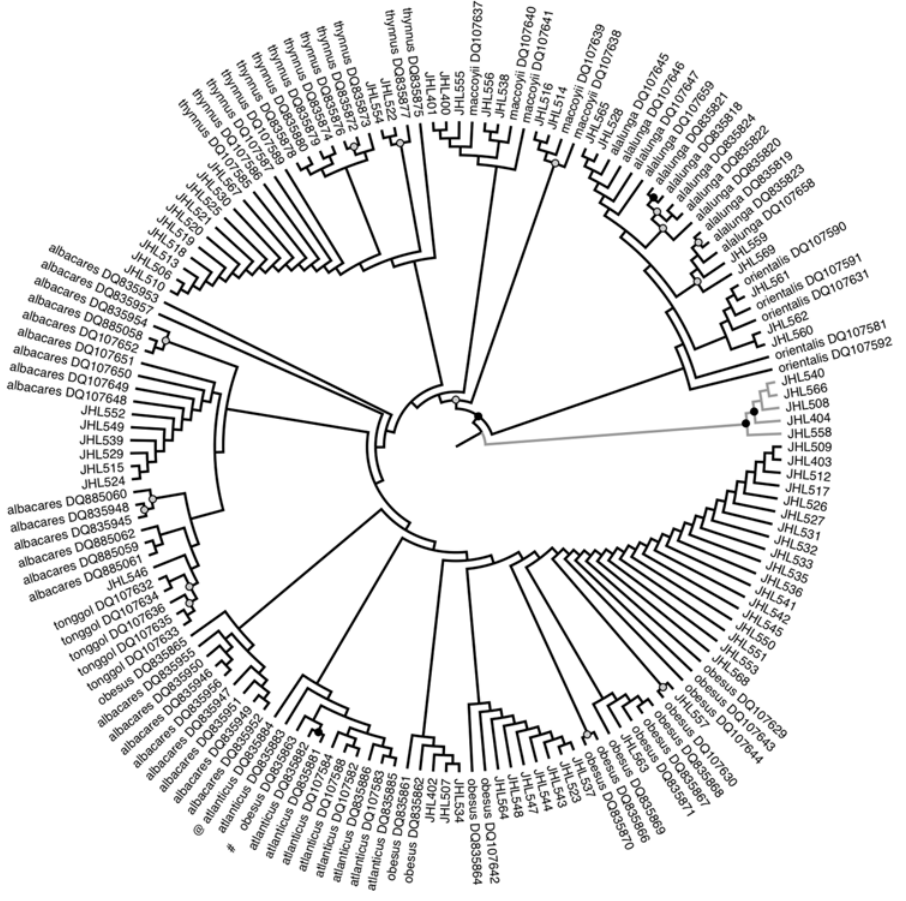
Figure 4. Neighbor-joining tree of cox1 sequences using the K2P substitution model. Node support was evaluated with 1000 bootstrap pseudoreplicates. Nodes with gray and black circles are supported at 50–79% and 80–100%, respectively. NCBI GenBank accession numbers are included in the taxon label of the reference sequences. The gray clade is composed of escolar sequences.